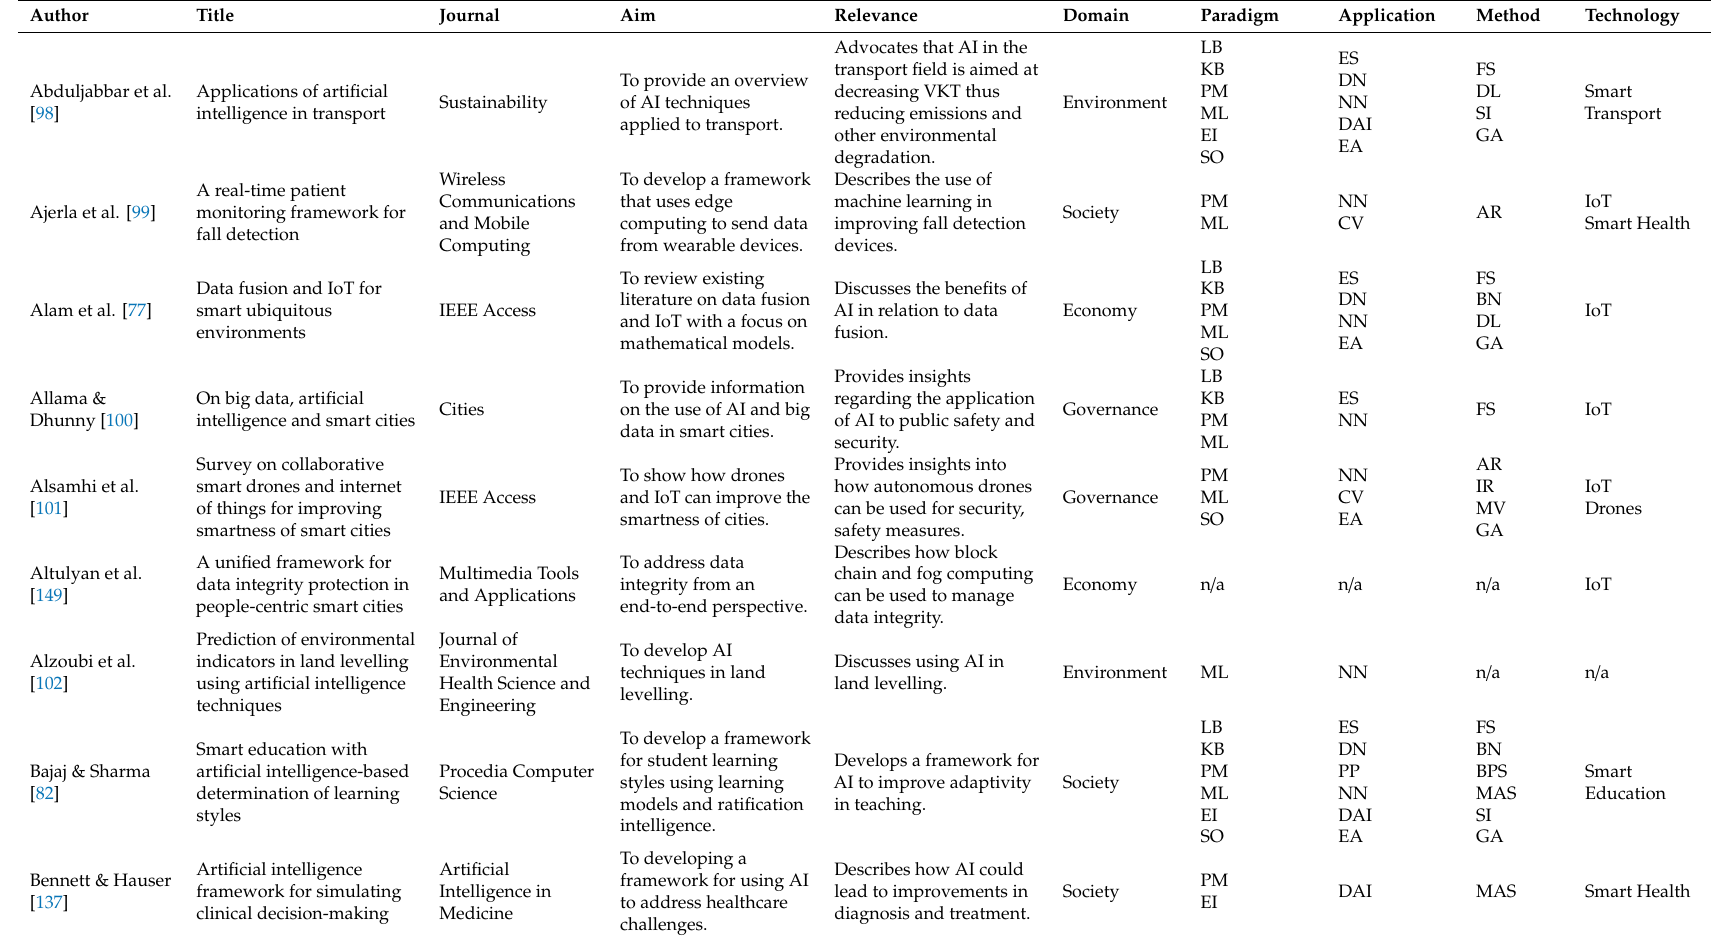
Table A1. Analysis Highlights of the Reviewed